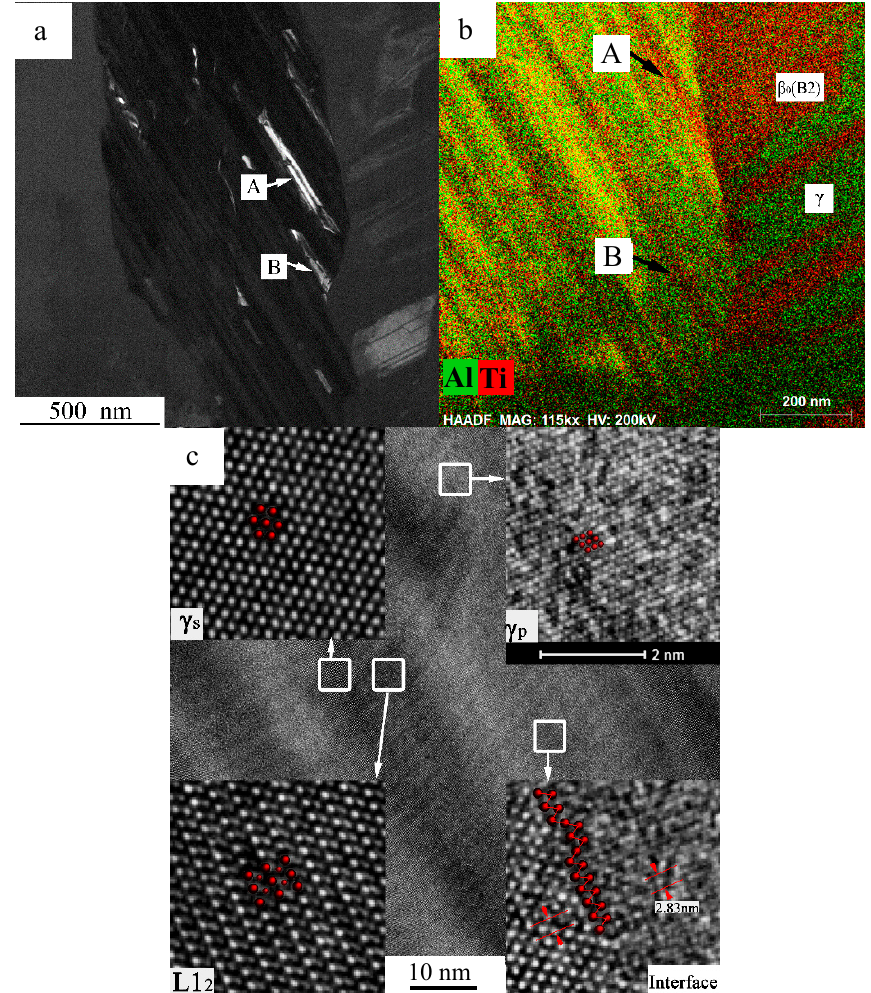
Figure 4. ( a ) Dark field and ( b ) scanning transmission electron microscope (STEM) area scan (step = 0.35 nm) images of the red square region in Figure 2c; ( c ) HRTEM images of the γ s , L1 2 and γ p phases with B = <101] γ s . The red dots in ( c ) represent the HRTEM atomic configurations of the γ s , L1 2 and γ p phases.